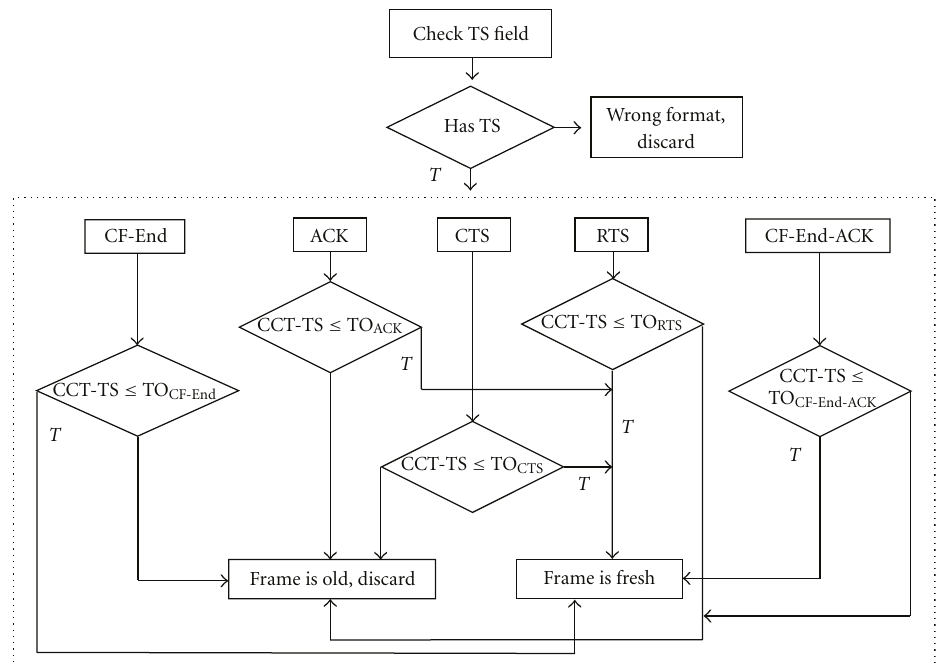
Figure 1: Replay attack preventing mechanism in the ACFNC